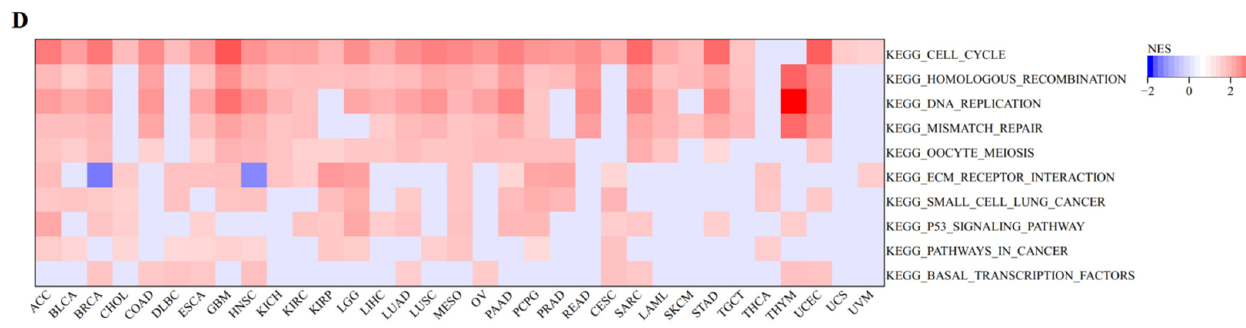
Figure 11. ( A ) Forty genes co-expressed with KIF18A in GeneMANIA. ( B ) GO enrichment analysis of KIF18A related genes. ( C ) KEGG enrichment analysis of KIF18A-related genes. ( D ) GSEA enrichment results.